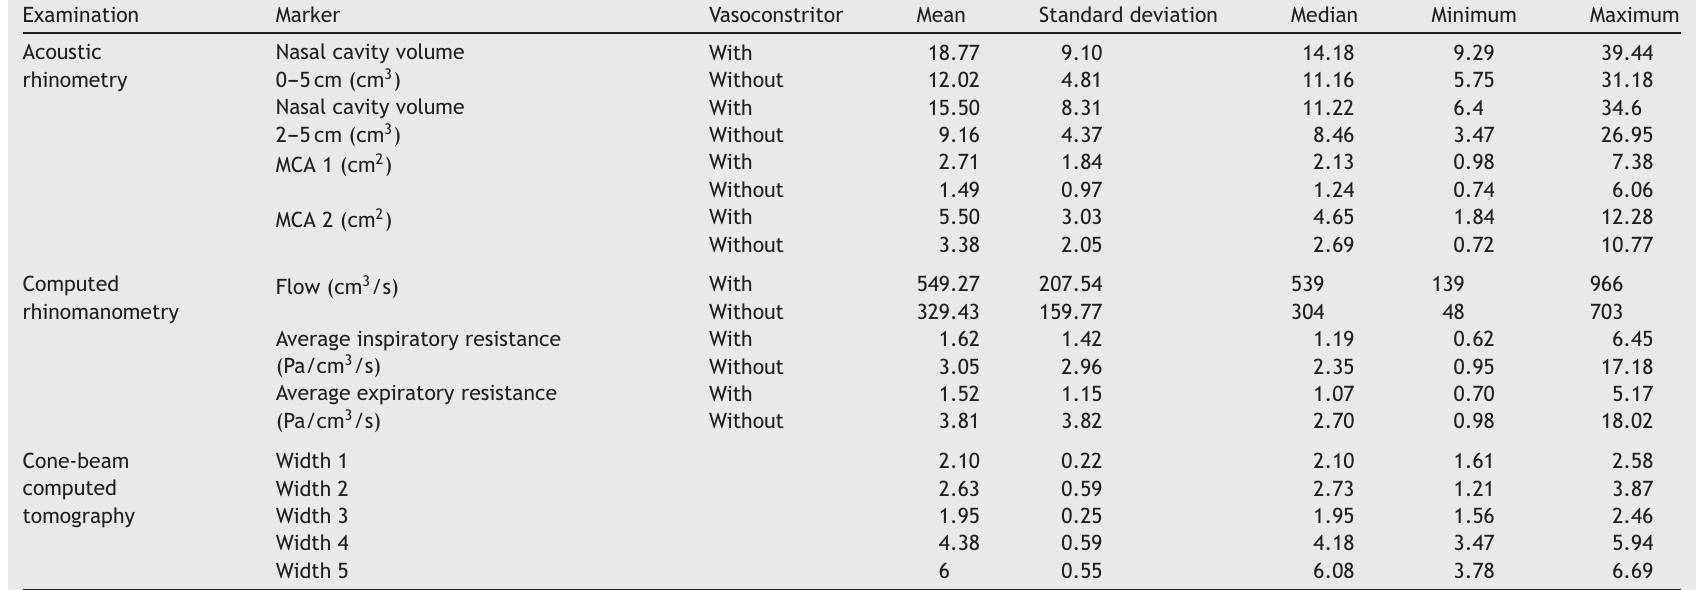
Descriptive analysis of acoustic rhinometry, computed rhinomanometry and cone-beam computed tomography of maxilla and nasal cavity in mouth breathers with transverse maxillary deficiency and comparison between the values of acoustic rhinometry and computed rhinomanometry tests, with or without the use of nasal